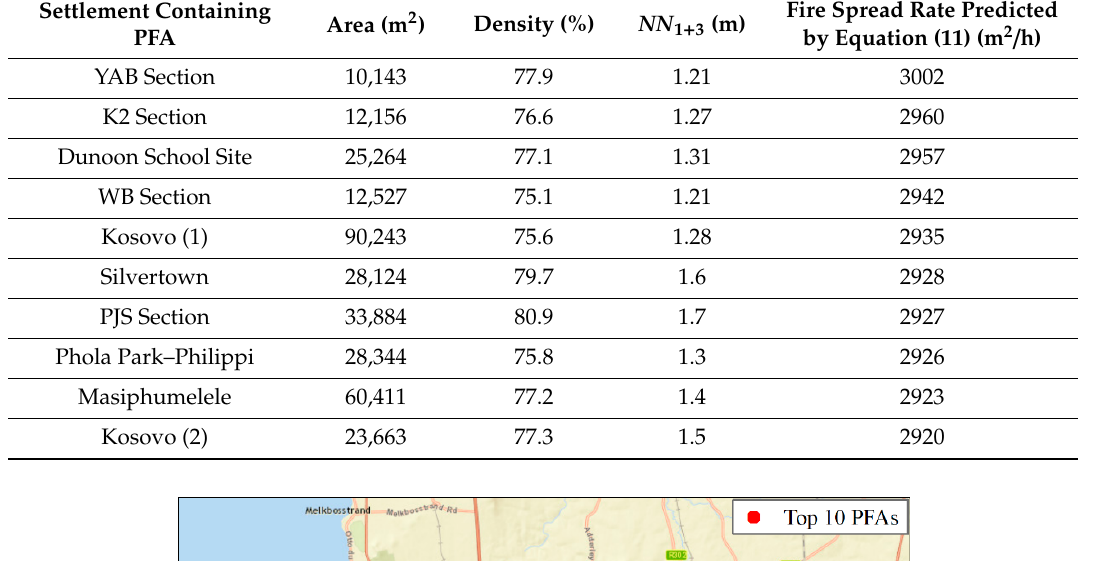
Table 3. PFAs with the highest fire spread rates of the 127 PFAs studied in Cape Town, with their corresponding spatial metrics.